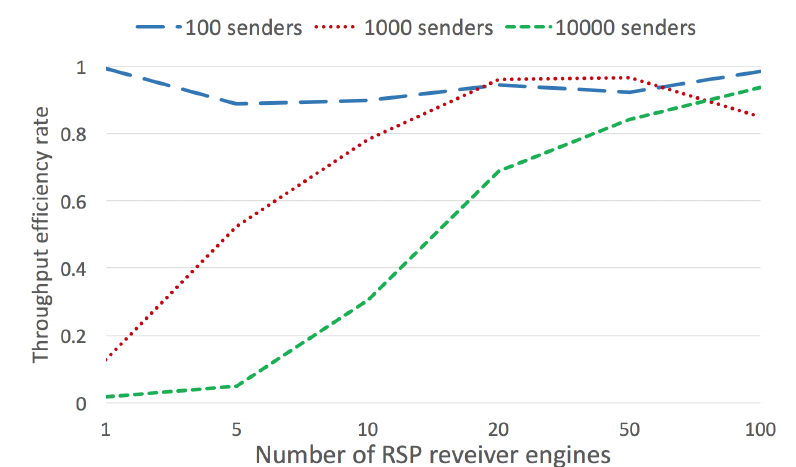
Figure 24. Throughput efficiency vs. number of RSP receivers without processing, for different sets of concurrent